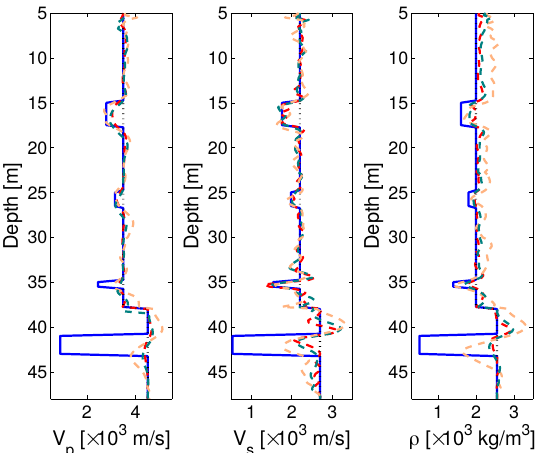
Figure 9. Cost function value evolution for each iteration: comparison of cost function (normalized) over 40 iterations for each acquisition setup.